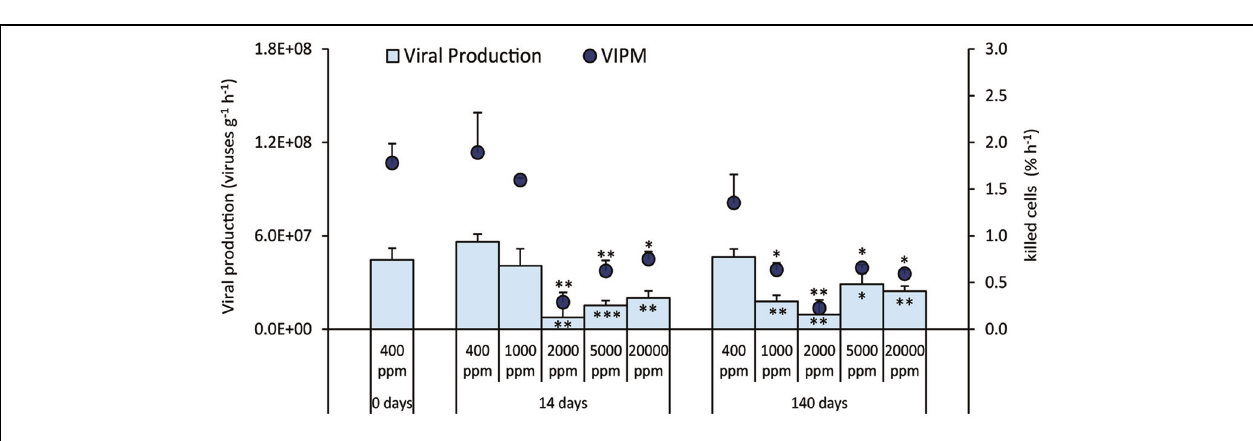
FIGURE 5 | Rates of viral production and virus-induced prokaryotic mortality (VIPM) in the different high-CO 2 experimental systems (1,000–20,000 ppm) and in the controls (i.e., 400 ppm), showing mean and relative SDs values. Significant differences between treatments and controls are indicated with asterisks: ∗ p < 0.05, ∗∗ p < 0.01, and ∗∗∗ p <